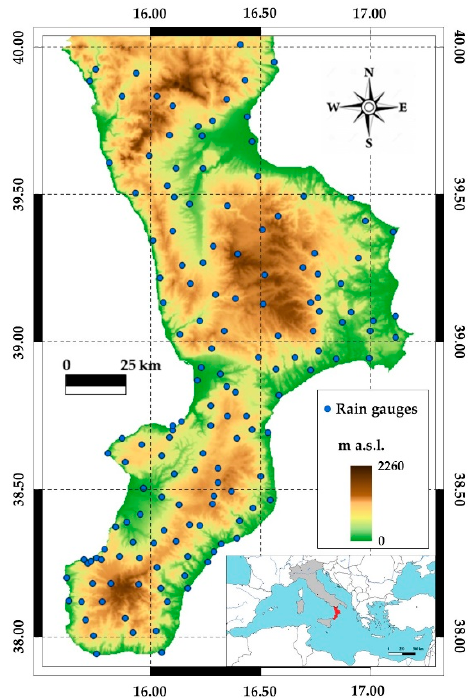
Figure 1. Location of rain gauges in Calabria region (southern Italy) .